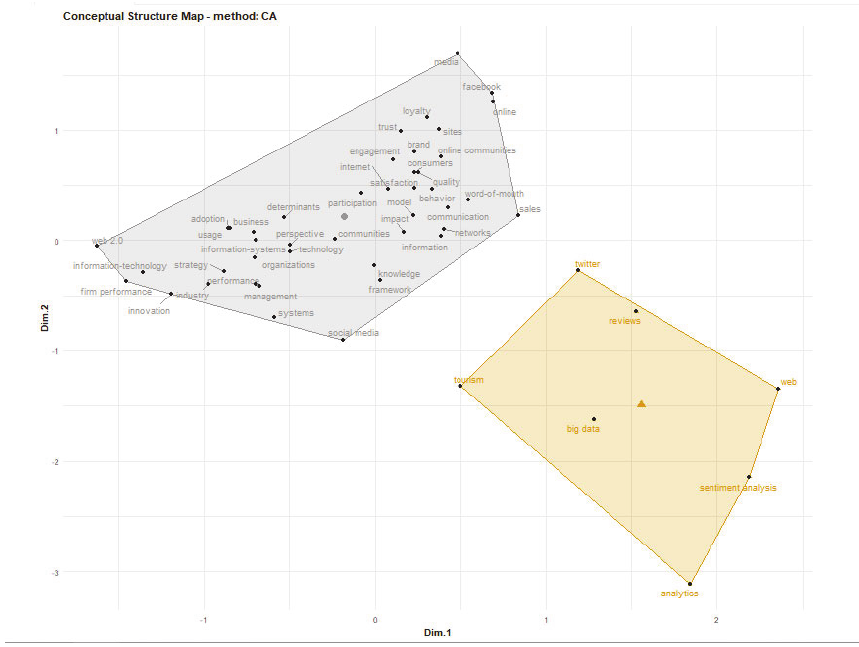
Fig. 8. Co-occurrence network